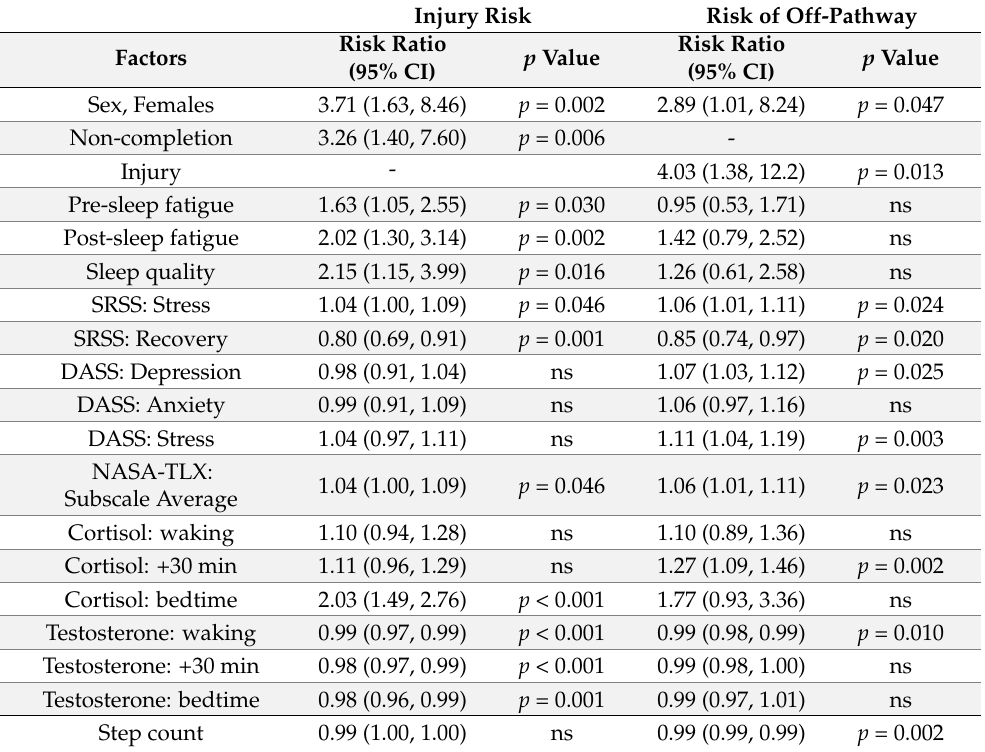
Table 4. Factors explaining the risk of recruit injury and off-pathway deviation during